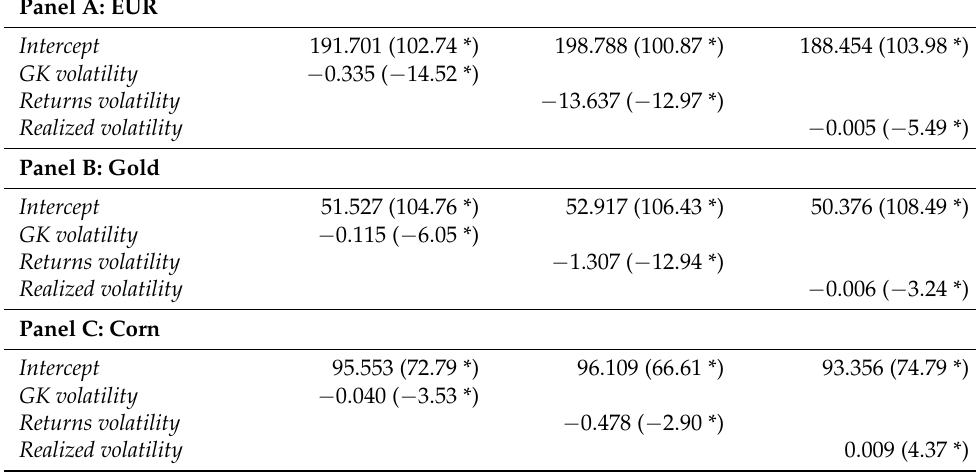
Table 3. Volatility and depth frequency. This table presents the coefficient estimates for the